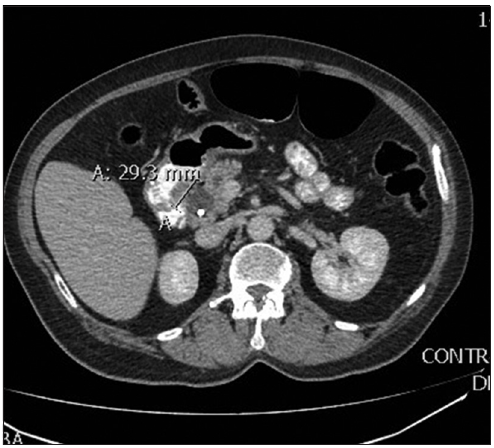
FIGURE 1. Periampullary lesion on computed tomography scans of the abdomen.